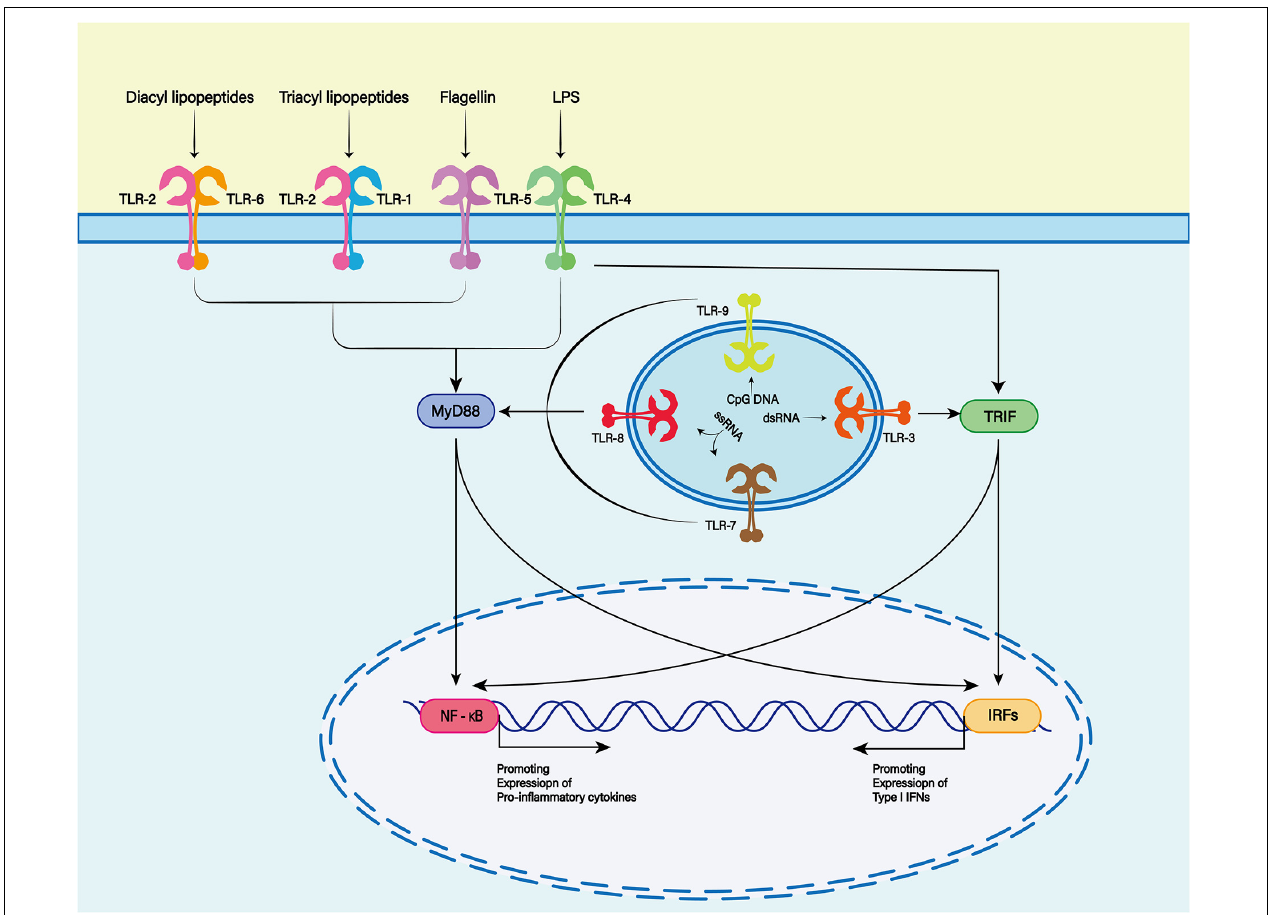
FIGURE 2 | The Toll-like receptor (TLR) family plays a key role in recognizing antigens produced by microorganisms. To date, 13 TLR family members have been discovered. TLR1, 2, 4, 5, and 6 were expressed on the cell surface, while TLR3, 7, 8, and 9 were expressed on the endosome membrane. Toll-like receptors are membrane receptors composed of extracellular domains, single transmembrane helical domains and intracellular signaling domains, which can bind to different ligands (TLR2 and TLR1 or TLR6 complexes recognize lipoproteins or lipopeptides, TLR3 recognizes double-stranded RNA, TLR4 recognizes lipopolysaccharides (LPS), TLR5 recognizes bacterial flagellins, TLR7 or TLR8 recognizes single-stranded RNA, and TLR9 recognizes CpG rich in hypomethylated DNA). When the TLR binds to the respective ligands, different downstream signals can be activated to produce different biological